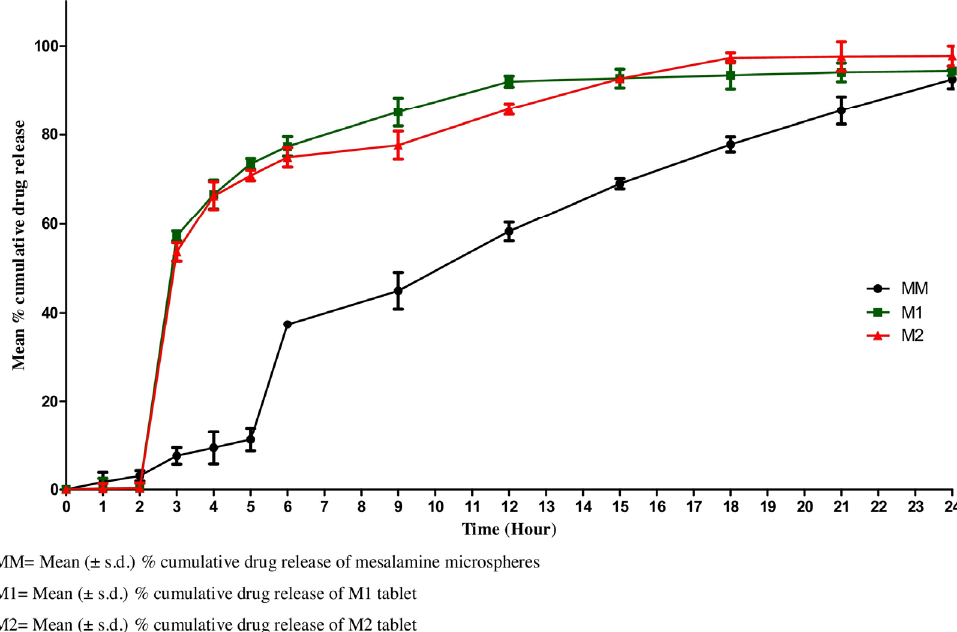
Figure 15. Mean ( ± s.d.) percentage cumulative release of mesalamine microspheres [xanthan gum and guar gum hydrogel] and its marketed preparations in the presence of 4% w / v rat cecal contents. Reproduced from [135] with permission.